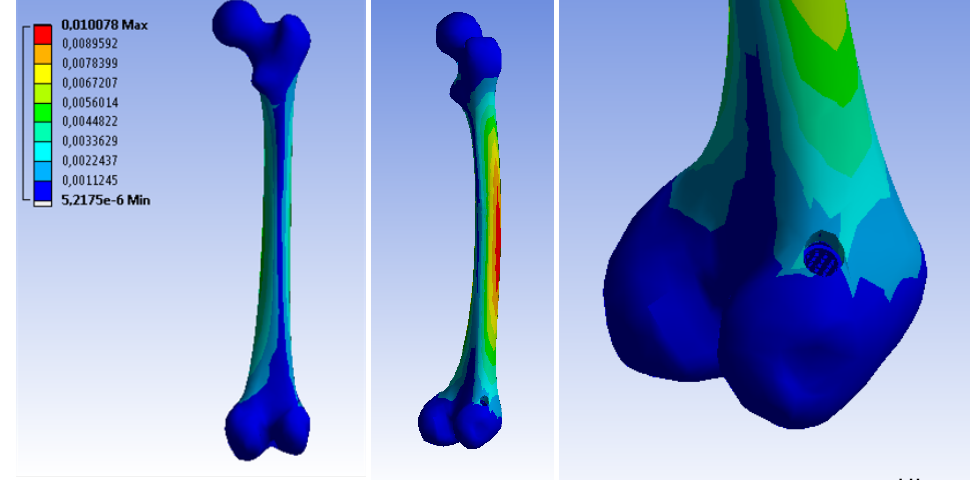
Figure 22. Stresses in the cortical bone tissue.